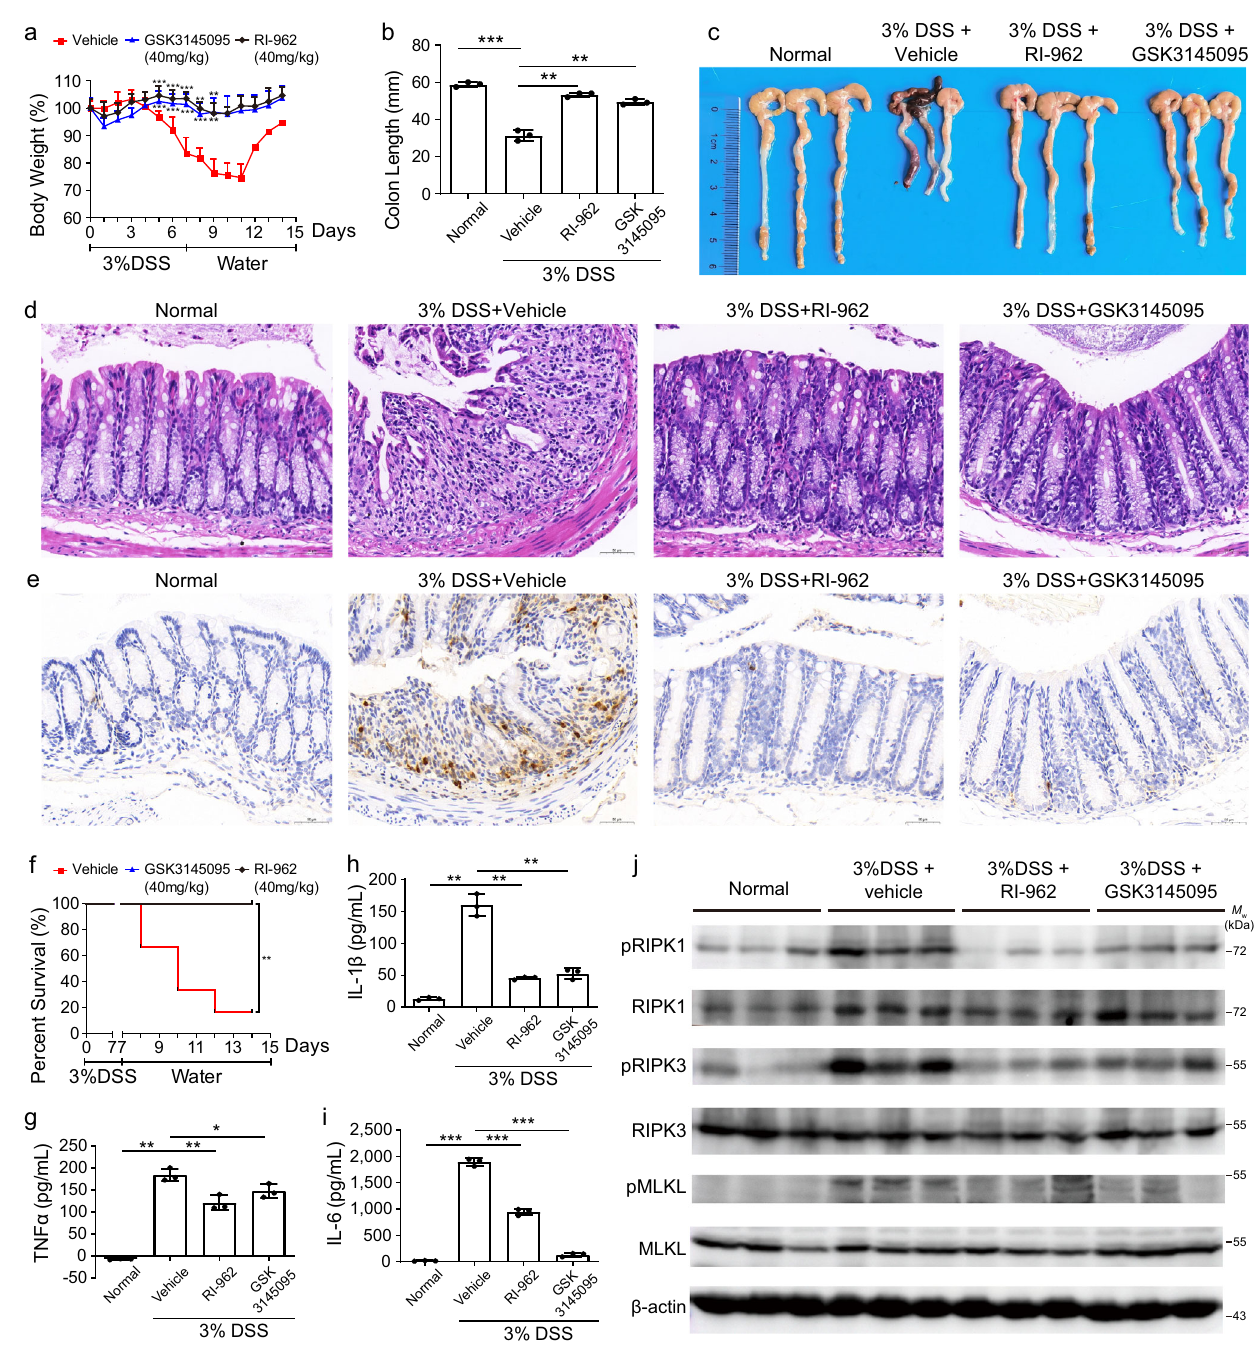
Fig. 9 | RI-962reduces in fl ammationin acuteDSS-inducedcolitis. DSS (3%) was administered to C57BL/6 female mice via drinking water for 7 d. After 7 d, the DSS water was replaced with fresh water. Vehicle, RI-962 (40mg/kg), or GSK3145095 (40mg/kg) was injected intraperitoneally once a day for 10 d. a Body weight changes in the mice treated with vehicle ( n =9), RI-962 ( n =10), and GSK3145095 ( n =10) after the DSS induction of colitis. Data are presented as mean±standard deviation, ** p -value<0.01, *** p -value<0.001 by two-tailed unpaired Student ’ s t - test. b , c The mice ( n =3) were sacri fi ced after the DSS induction of colitis for 7 d, and the lengths of the colons from each group of mice were measured. Data are presented as mean±standard deviation, *** p -value<0.001 by two-tailed unpaired Student ’ s t -test. d , e Themice( n =3)ineachgroupweresacri fi cedonday7,andthe colon tissues were collected for analysis. d Representative H&E staining of the colon tissues from the mice on day 7 (scale bar=50 μ m). e Representative